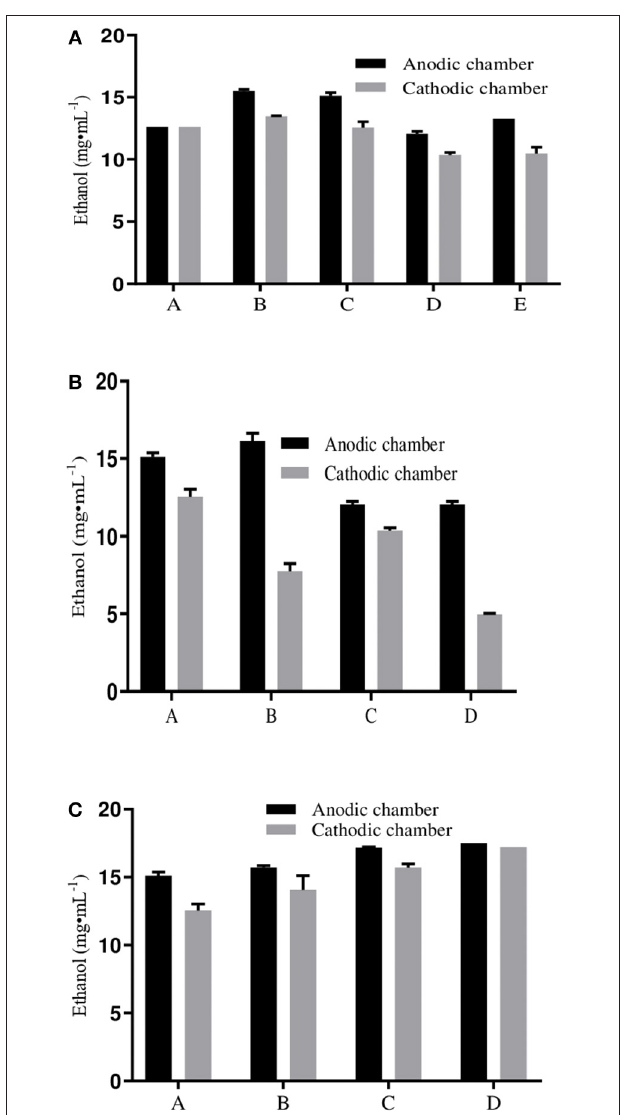
FIGURE 5 | Ethanol production with different electron transport enhancement systems. (A) Use of yeasts in various combinations in ECC (A: CDBT2 normal fermentation; B: CDBT2/CDBT2 in Electrochemical cell; C: CDBT2/CDBT7 in Electrochemical cell, D: CDBT2/CDBT7 normal fermentation, E: CDBT2/CDBT7 mixed culture). (B) Use of graphite electrode immobilized with CDBT7 yeast strain [A: Graphite cathode/Pt anode; B: Graphite cathode (immobilized with CDBT7)/Pt anode; C: Normal fermentation CDBT2/CDBT7; D: Normal fermentation CDBT2/CDBT7 immobilized in graphite]. (C) Use of